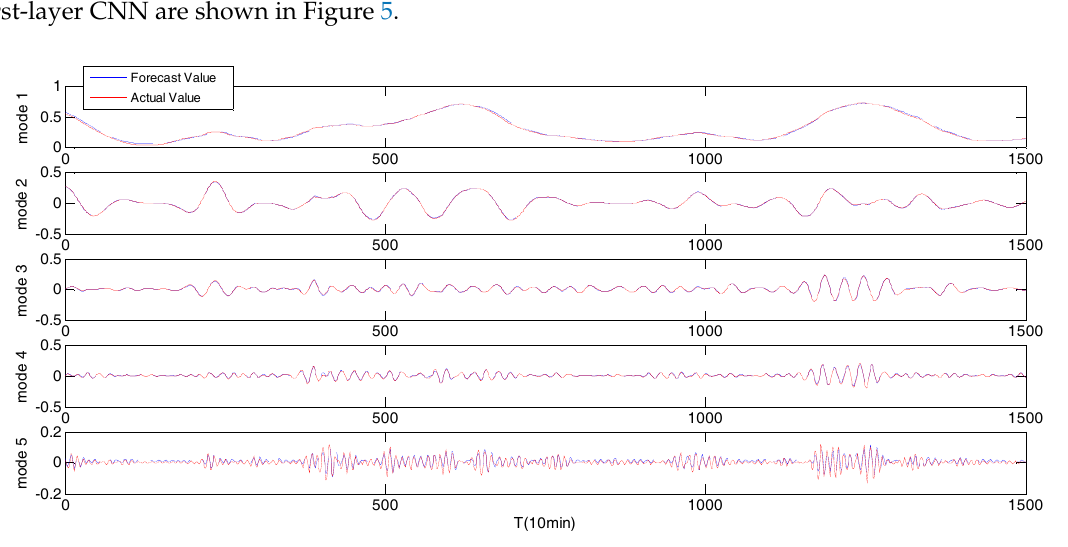
Figure 5. Forecasting results of the first-layer CNN based on the VPBC + PSO. VPBC: VMD + PSR + bi-level CNN.